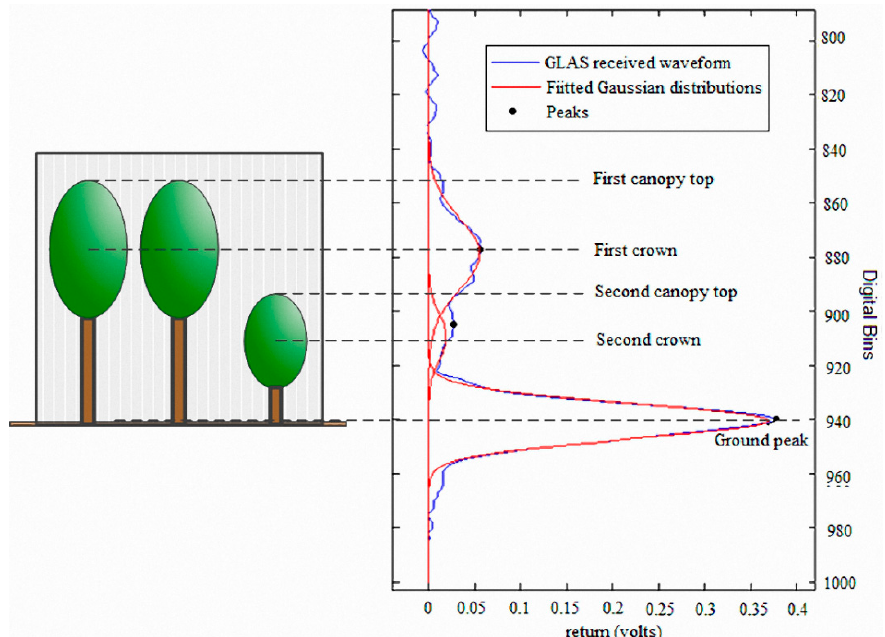
Figure 5. A schematic diagram of the refined Levenberg–Marquardt (RLM) Gaussian decomposition method. Two vegetation Gaussian signals corresponding to the two canopy height layers were decomposed by RLM.